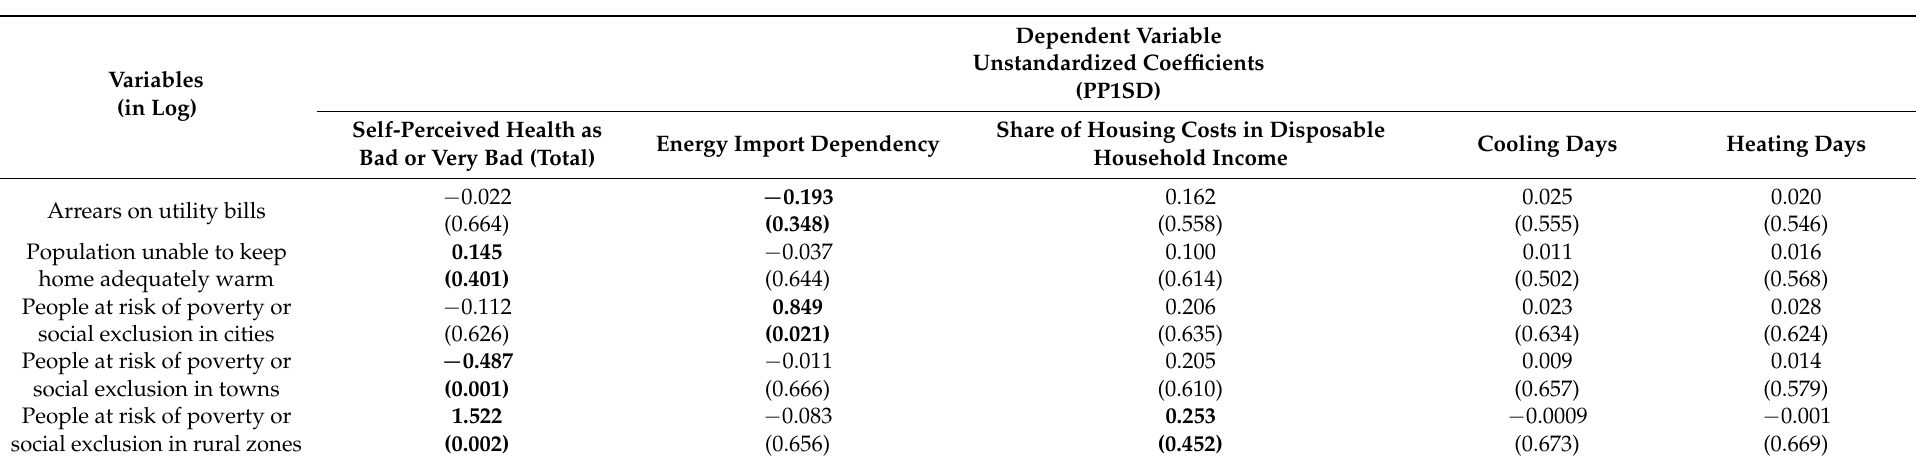
Table 9. The results of generalized ridge regressions for